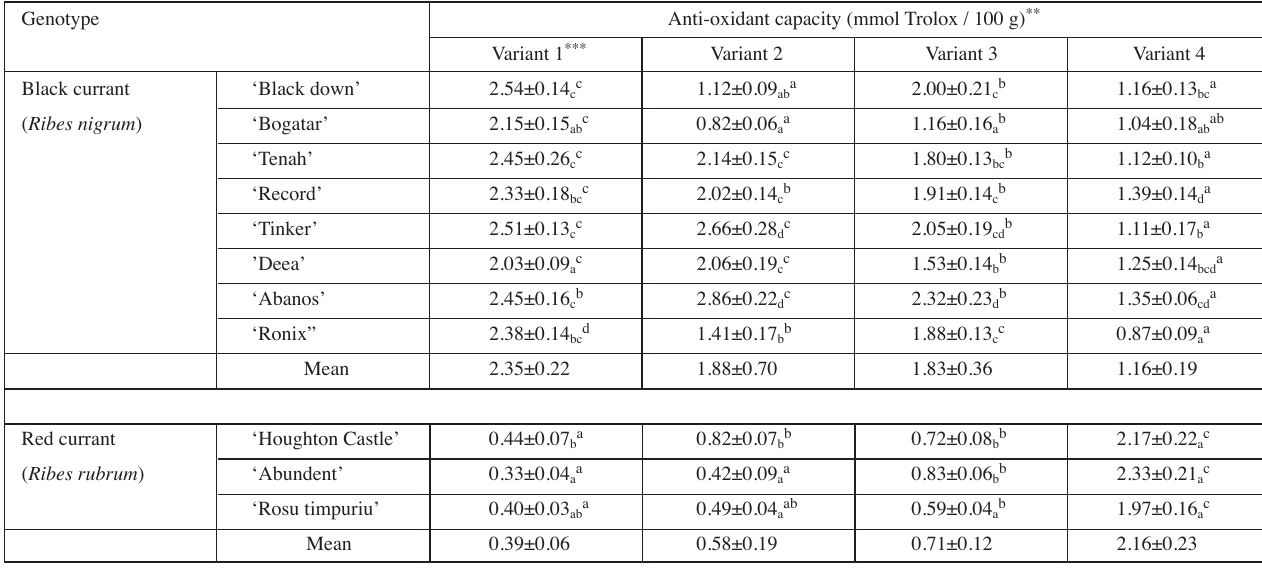
Tab. 2: Anti-oxidant capacity * of fruits from various cultivars of black and red currant